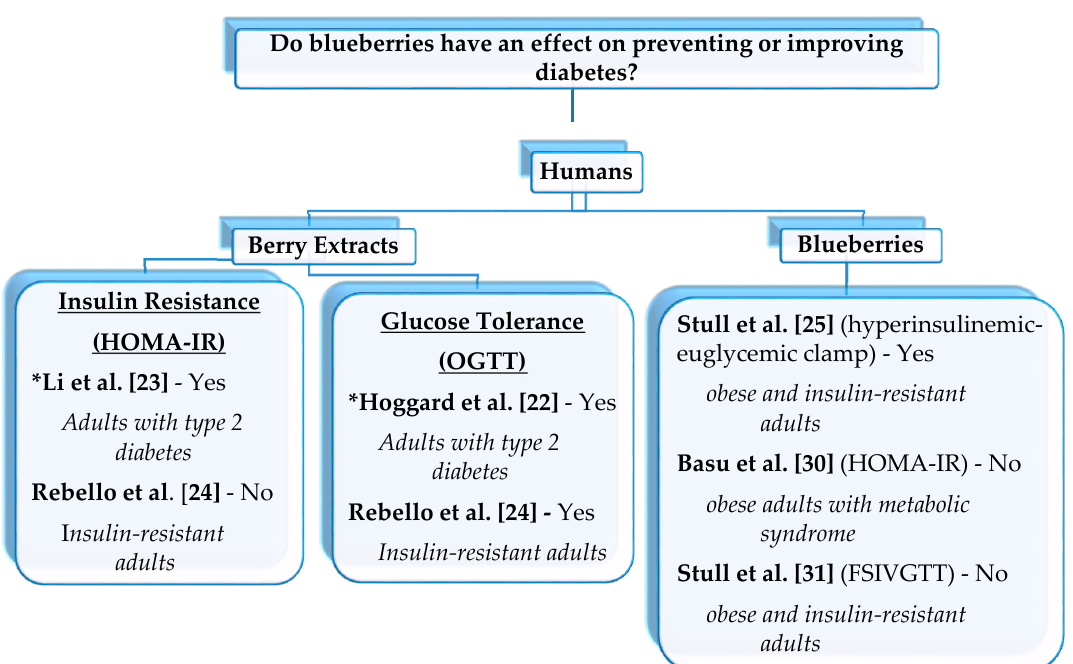
Figure 2. The effect of blueberries on preventing and improving type 2 diabetes in obese and insulin-resistant adults. Insulin resistance and/or glucose tolerance were assessed using HOMA-IR (homeostatic model assessment-estimated insulin resistance), FSIVGTT (Frequently sampled intravenous glucose tolerance test), and OGTT (oral glucose tolerance test). Rebello et al. [24], used HOMA-IR and OGTT and Stull et al. [25,31], used the clamp and FSIVGTT. * Studies that used bilberries.